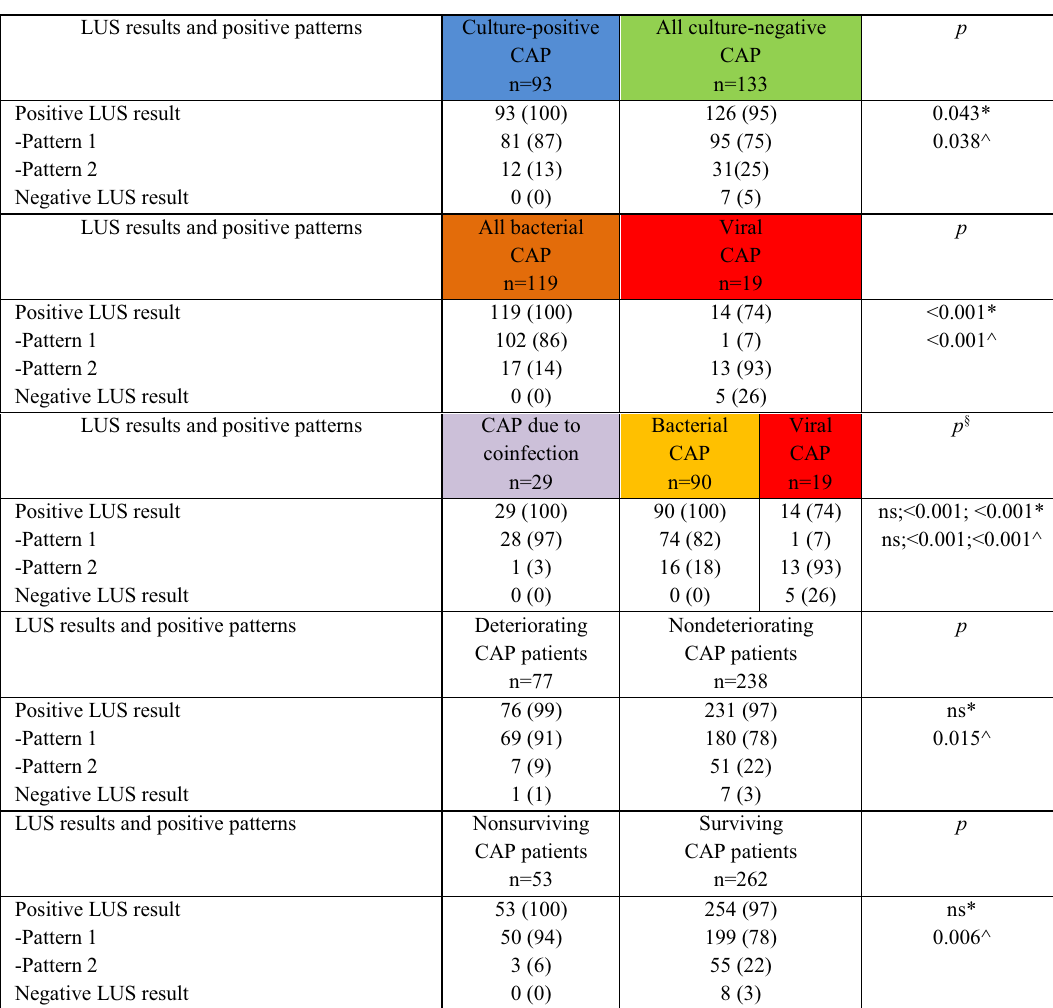
Table 3. Lung ultrasound results and positive patterns according to the outcomes of the second analysis. LUS lung ultrasound, CAP community-acquired pneumonia, ns not significant. The color of the heading refers to the color assigned to the specific microbiological cohort of community-acquired pneumonia in Figure S1. Please see Supplement for discursive definitions of each cohort. *Positive LUS result vs negative LUS result;